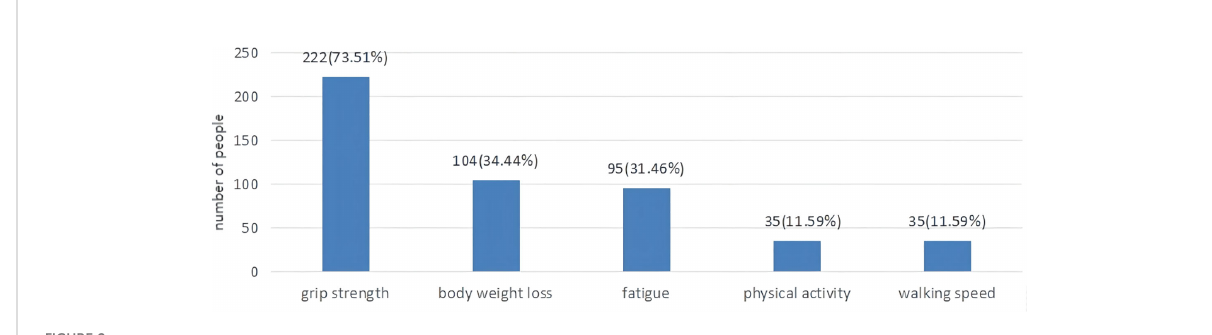
FIGURE 2 The proportion of lung cancer patients with chemotherapy according to fi ve frailty